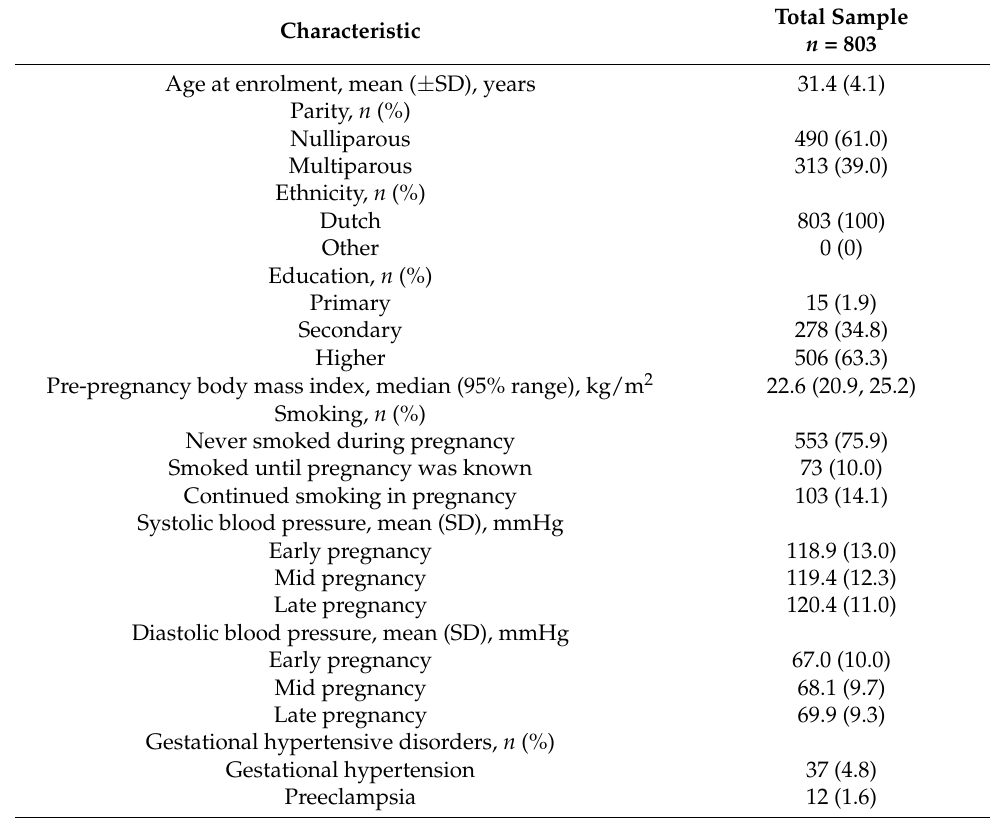
Table 1. General characteristics of the study